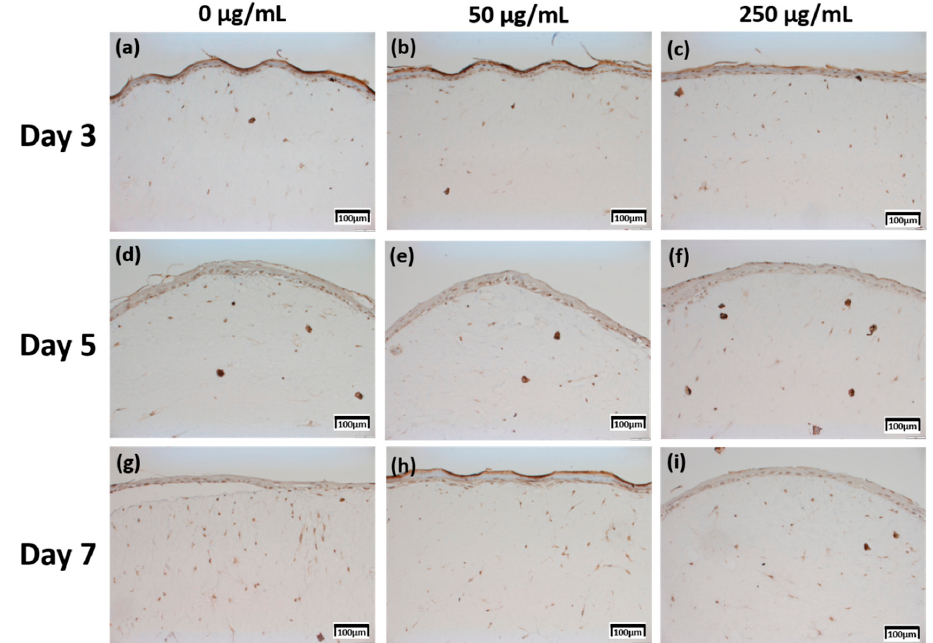
Figure 5. Immunohistochemistry stained images for filaggrin of 3D cell cultured sample for 3 days air exposure using culture media-treated CLLE concentrations of ( a ) 0 μ g/mL, ( b ) 50 μ g/mL, and ( c ) 250 μ g/mL; for 5 days air exposure using culture media-treated CLLE concentrations of ( d ) 0 μ g/mL, ( e ) 50 μ g/mL, and ( f ) 250 μ g/mL; and for 7 days air exposure using culture media-treated CLLE concentrations of ( g ) 0 μ g/mL, ( h ) 50 μ g/mL, and ( i ) 250 μ g/mL.